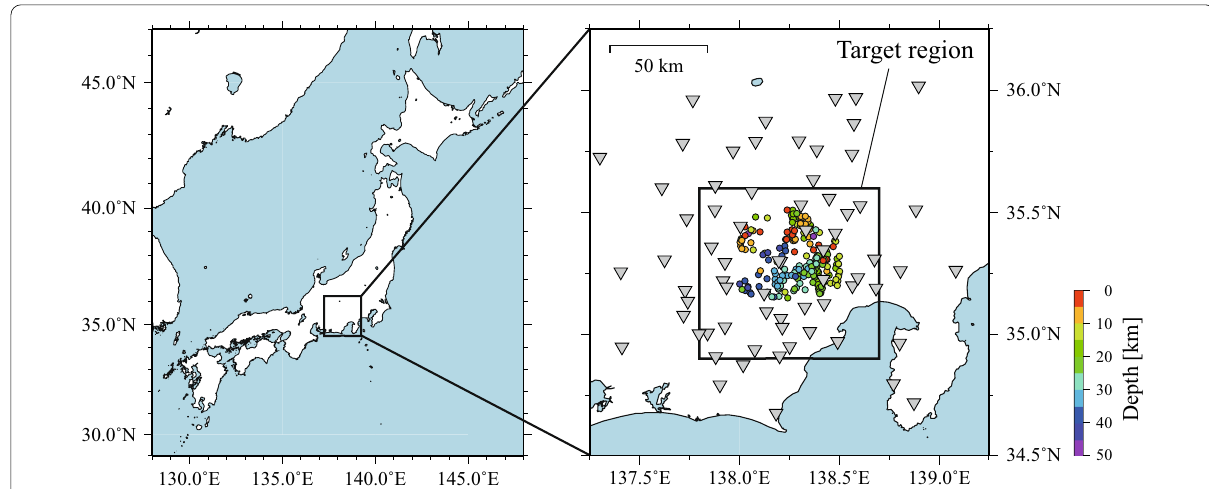
Fig. 2 ( Left ) Map of the target region (bold rectangle) in Japan. ( Right ) Distributions of epicenters and observation stations that were used in our synthetic test. Circles represent earthquake epicenters, and grey inverted triangles represent observation stations. Epicenters are color-coded by